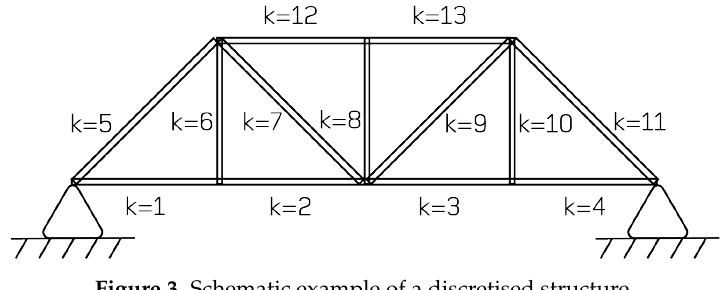
Figure 3. Schematic example of a discretised